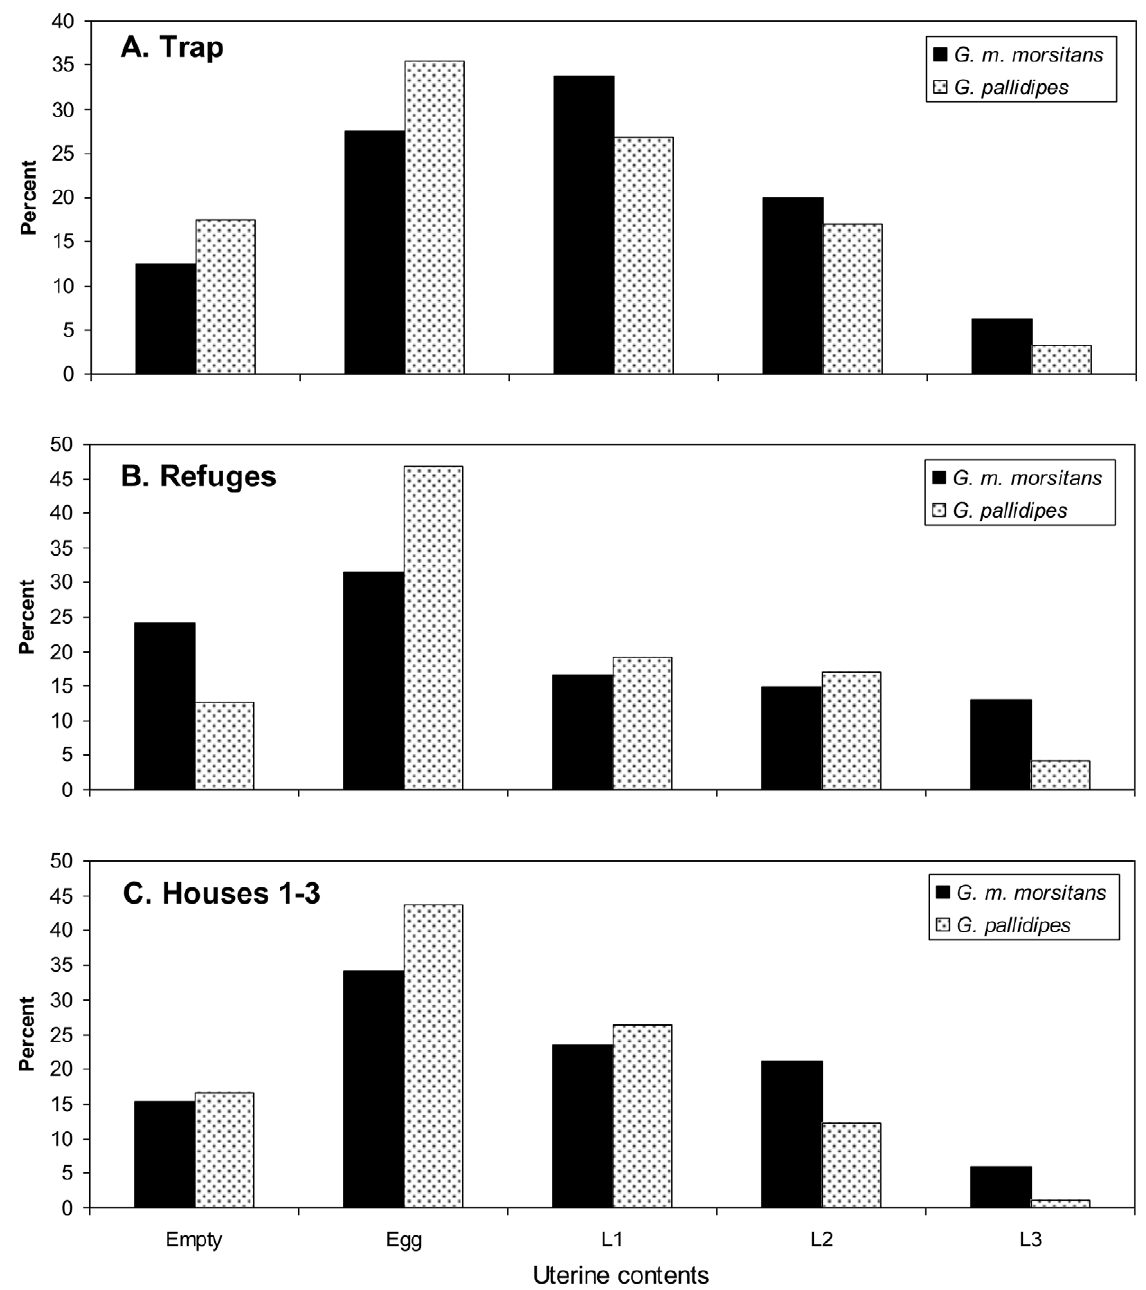
Figure 6. Percent distribution of uterine contents of catches at the trap (A), refuges (B) and Houses 1–3 (C). L1, L2 and L3 are first, second and third instar larvae, respectively. Sample sizes for the trap, refuges and houses were 80, 54 and 85, respectively, for G. m. morsitans and 601, 47 and 295, respectively, for G. pallidipes .